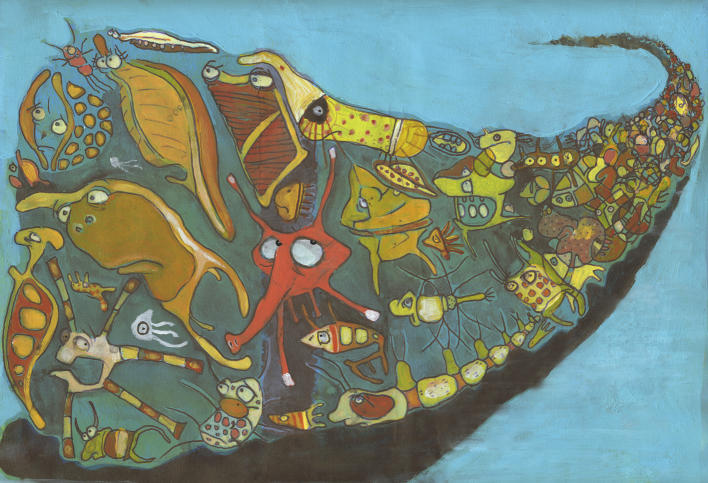
Zooming into the bloom: cell-to-cell signaling in the sea. (Illustration: Nivi Alroy)